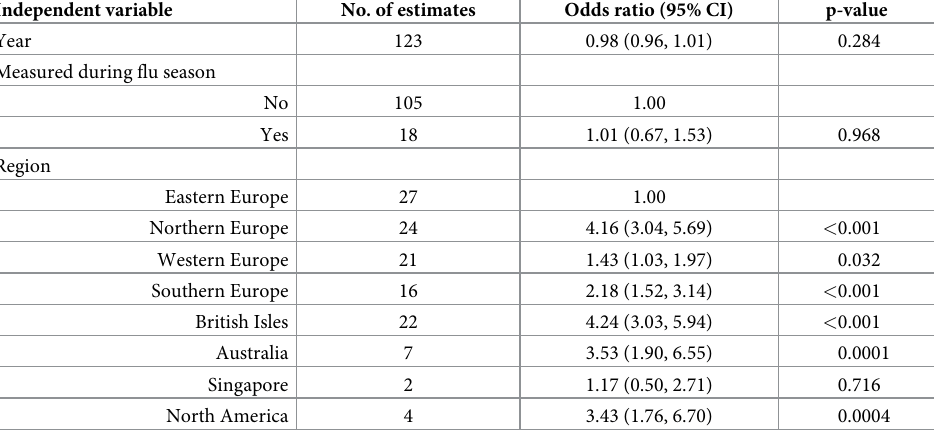
Table 3. Meta-regression of point prevalence estimates of antibiotic use in long-term care facilities (N =